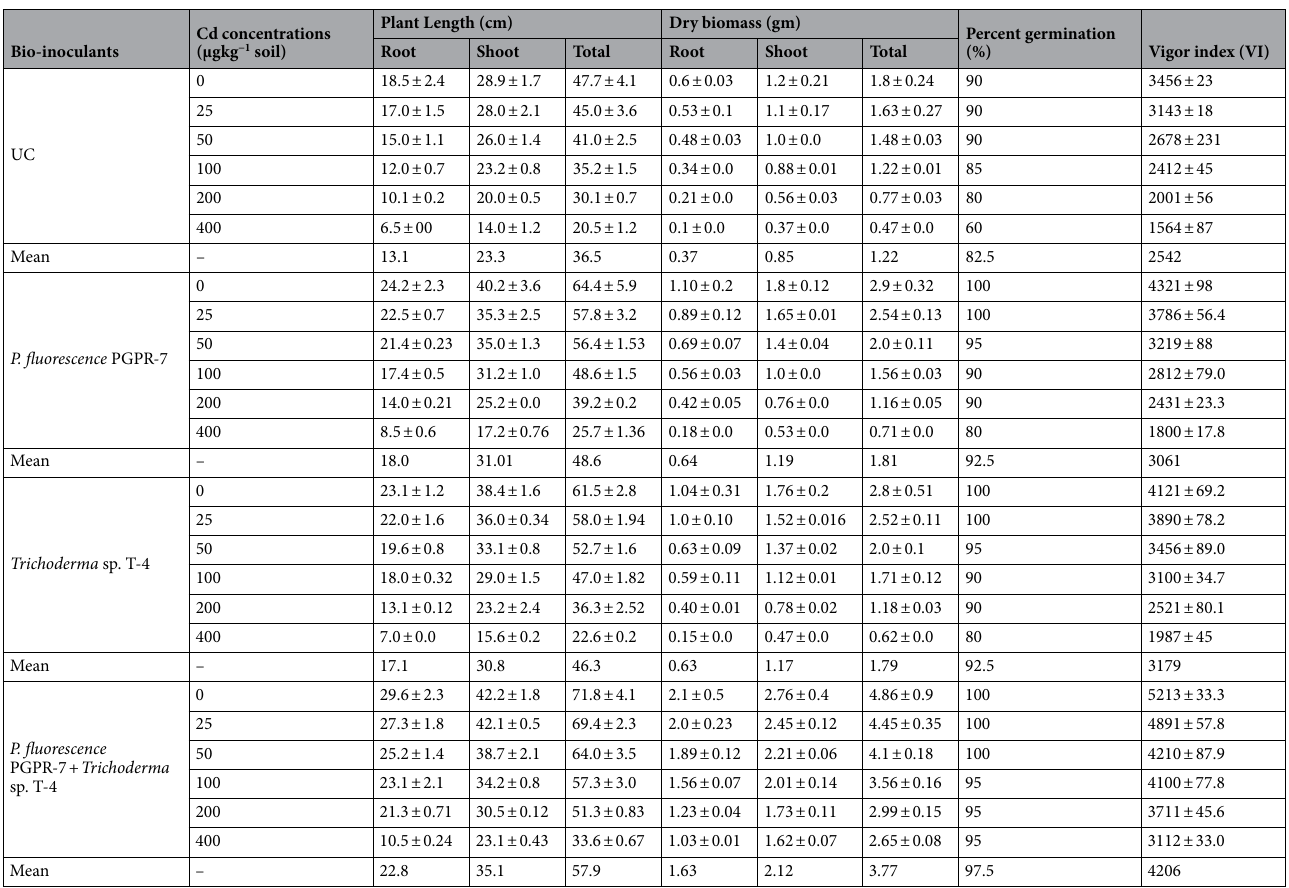
Table 3. Single and combined inoculation impact of metal tolerant Pseudomonas fluorescence PGPR-7 and Trichoderma sp. T-4 on biological parameters of chickpea raised in Cd affected soils. Each value is a mean of three replicates where each replicate constituted three plants/pot. Mean values are significantly at P ≤ 0.05. Means followed by similar alphabets are different from each other according to DMRT test.